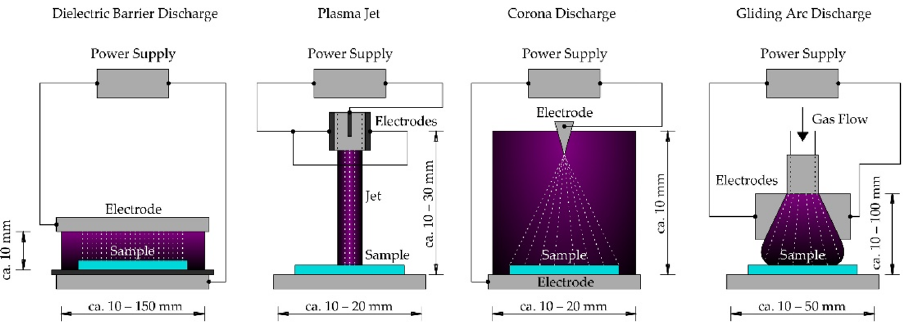
Figure 1. Schematic drawing of diverse cold atmospheric pressure plasma